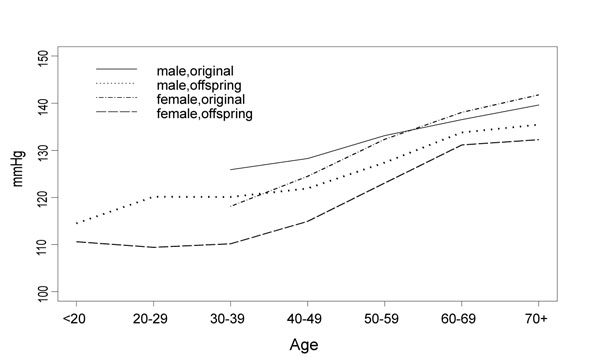
Sex- and age-specific mean of systolic blood pressure